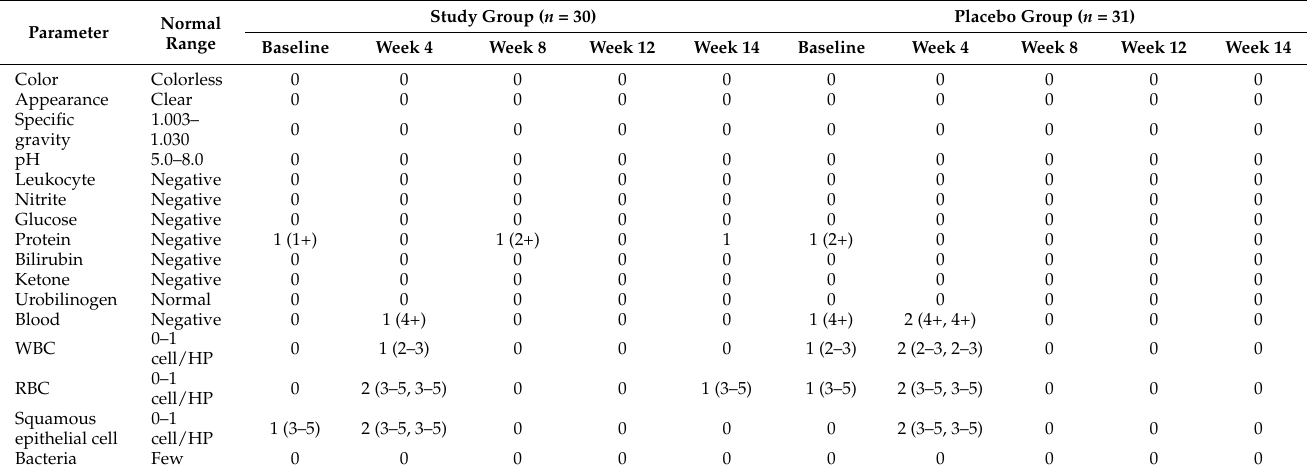
Table 4. Number of participants with abnormal urinalysis parameters.